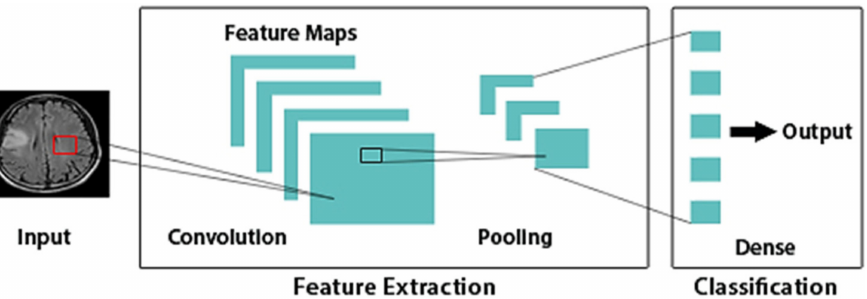
Figure 2. Simple CNN architecture. Dense: Fully connected